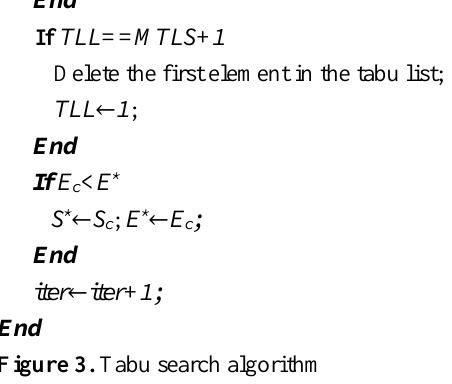
Figure 3. Tabu search algorithm